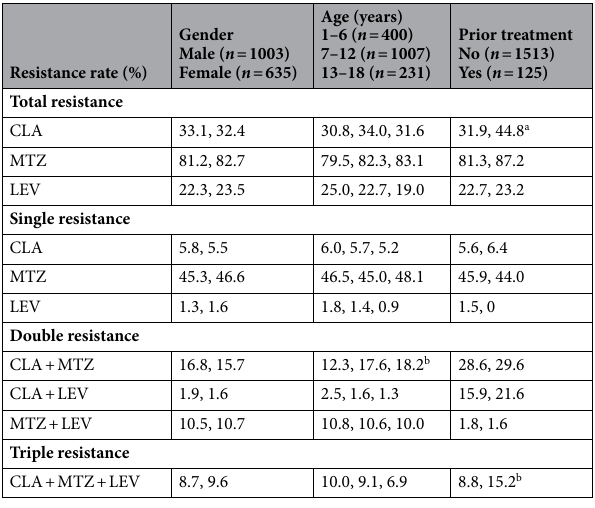
Table 3. Factors associated with antibiotic resistance of H . pylori from 2015 to 2020. CLA, clarithromycin; MTZ, metronidazole; LEV, levofloxacin. a P < 0.01. b P < 0.05.